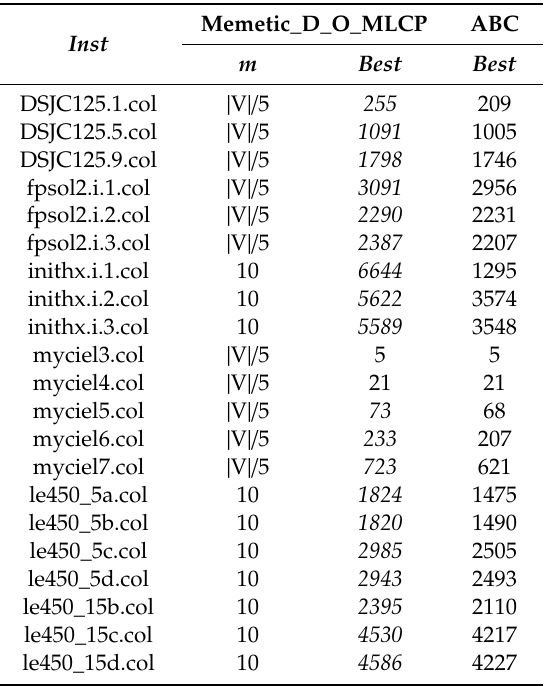
Table 4. Comparison results on Memetic_D_O_MLCP and